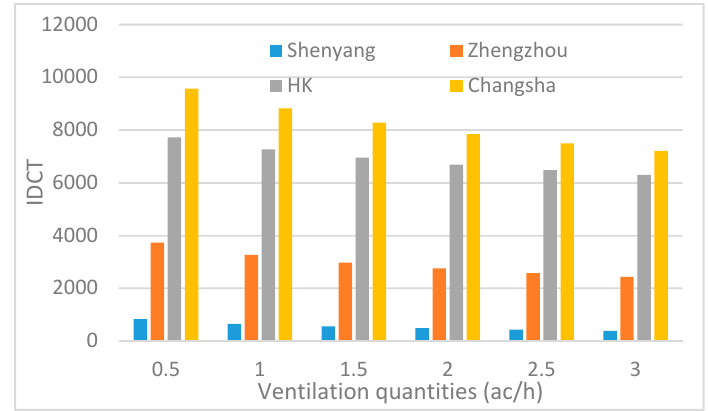
Figure 7. The relationship of I DCT and the change of ventilation quantities with the above-mentioned good ventilation periods (0:00~9:00)